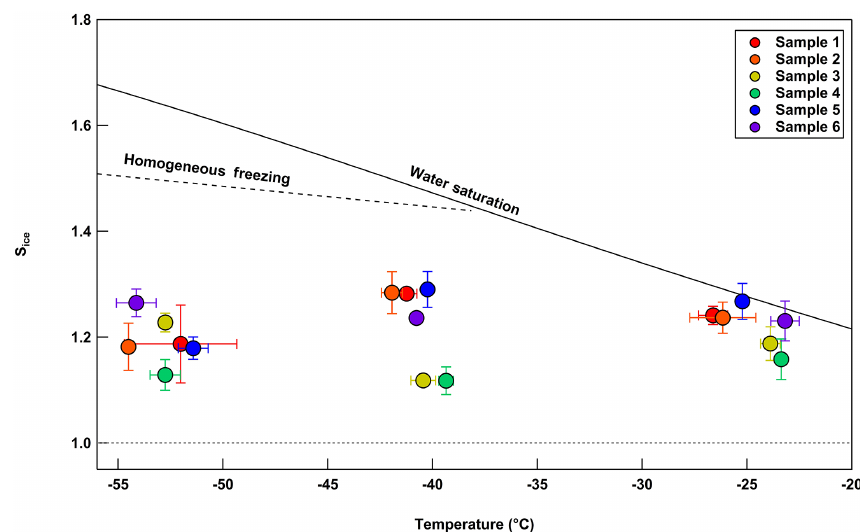
Figure 10. Depositional ice nucleation experiments on samples 1–6 plotted by S ice versus temperature. The values plotted here are of the onset conditions of depositional ice nucleation. For our experiments, this refers to the first particle to nucleate ice out of the 10 4 particles deposited on the disc in total, thus a percent activated fraction of 10 − 4 . Although temperatures measured were not exactly − 25, − 40, and − 55 ◦ C, these values are used for brevity for all samples within each grouping shown above. Nucleation occurring at − 25 ◦ C could also be due to immersion freezing.